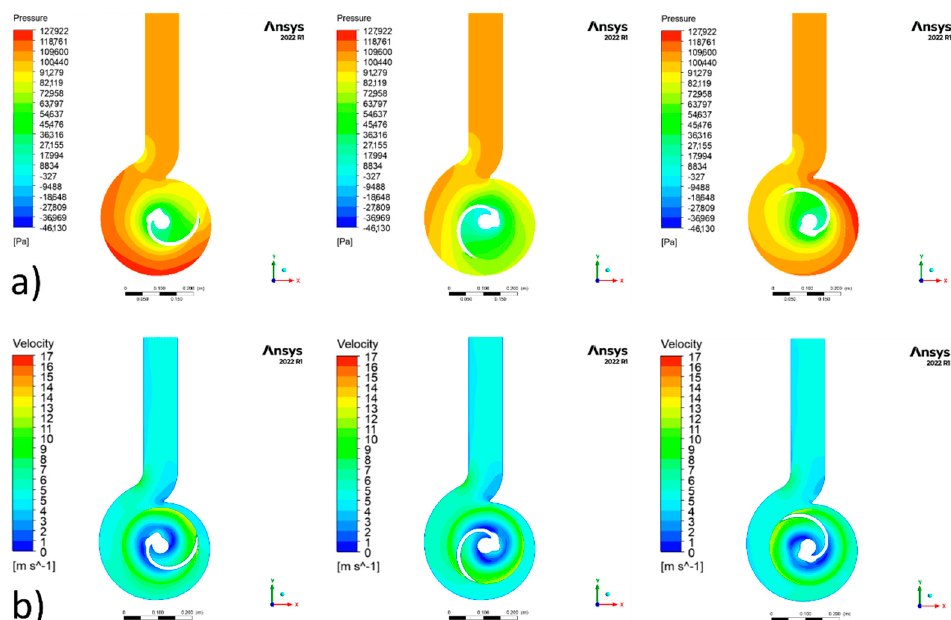
Figure 8. Pressure ( a ) and velocity ( b ) field at 36 l s –1 .